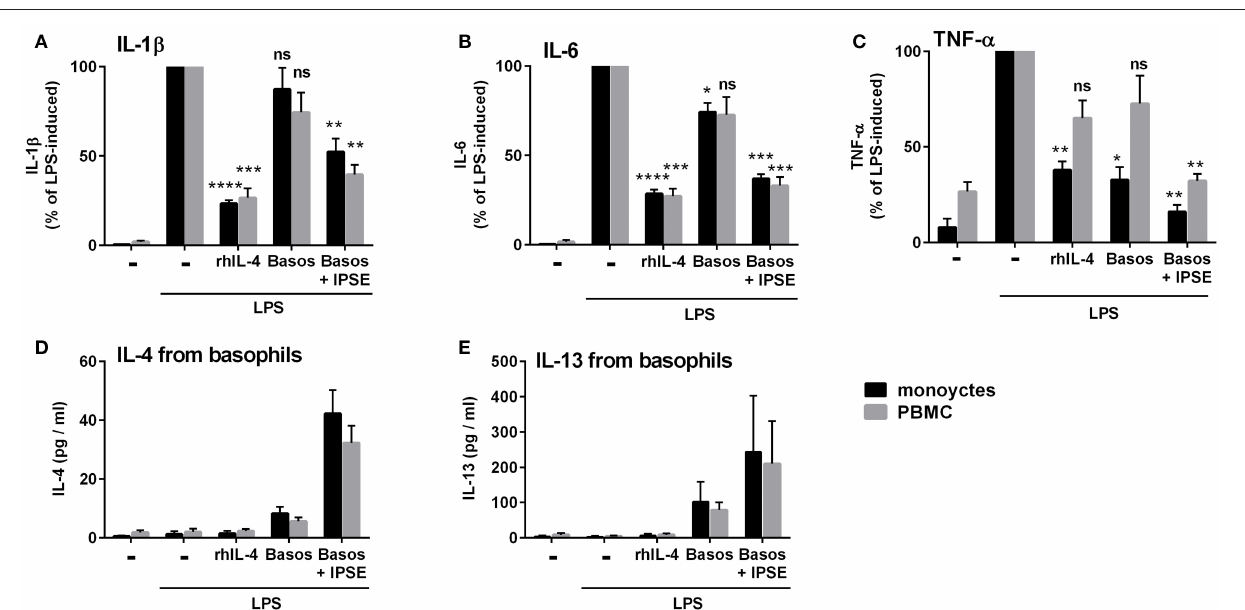
FIGURE 10 | IPSE/alpha-1-triggered basophil IL-4 inhibited the release of IL-1 β (A) , IL-6 (B) , and TNF- α (C) from LPS-activated monocytes in the context of whole PBMC. Inhibition correlated with IL-4 (D) and IL-13 (E) release from basophils. The experiment shown in Figure 1 was repeated with PBMC instead of purified monocytes. Data for PBMC are presented as mean ± SEM, n = 4; (TNF- α : n = 3). Statistics were performed with the paired t -test; significance was shown vs. LPS without additions; ns, not significant, * p < 0.05, ** p < 0.01, *** p < 0.001, and **** p <